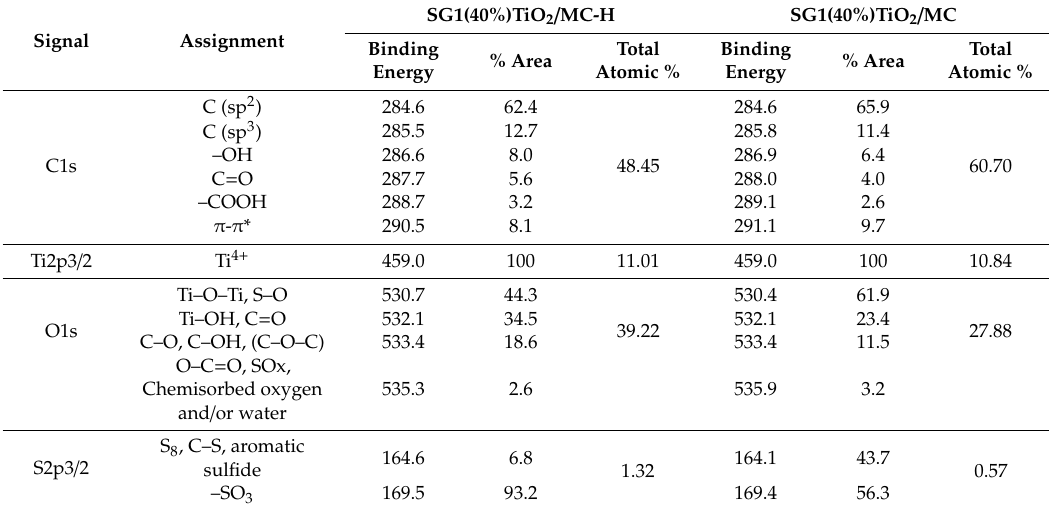
Table 3. X-ray photoelectron spectroscopy (XPS) results for SG1(40%)TiO 2 / MC-H and SG1(40%)TiO 2 / MC. Signal